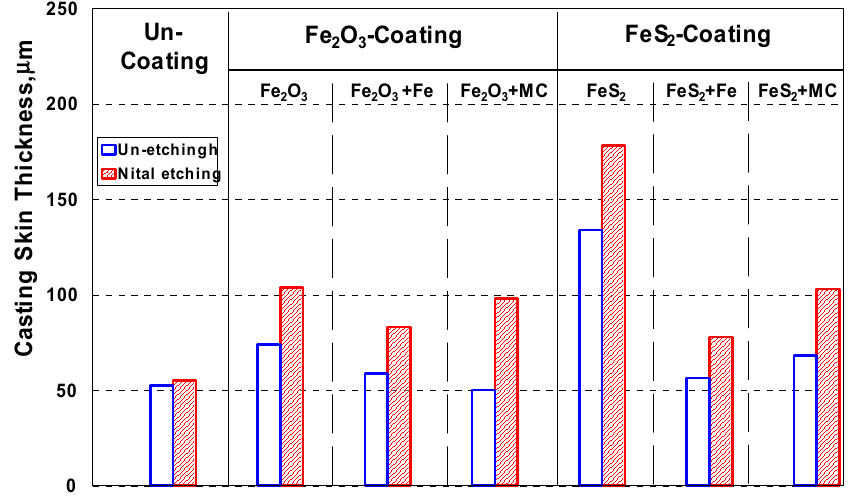
Figure 9. Average graphite degenerated surface layer (casting skin) thickness of experimented ductile irons.